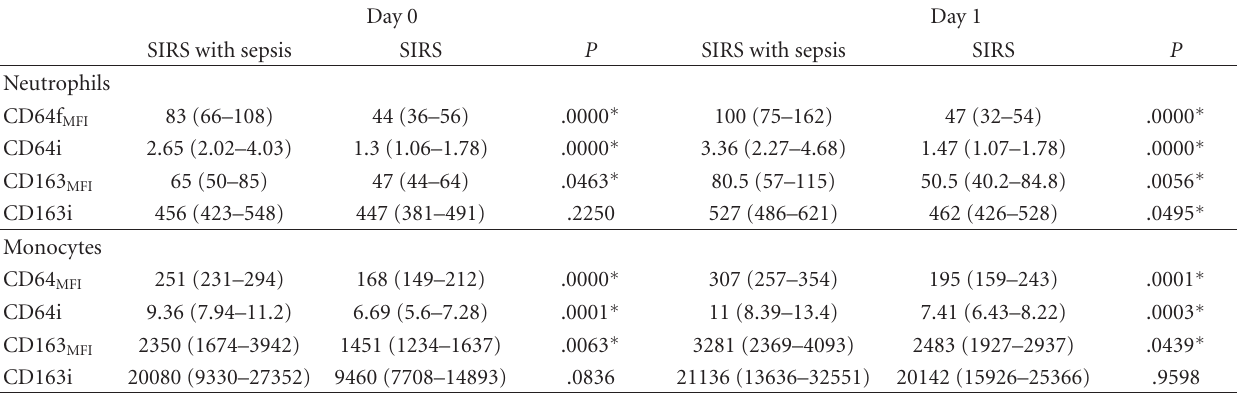
Table 2: Median CD64 and CD163 MFI and indexes (i) for neutrophils and monocytes with 95% confidence interval (CI) in critically ill neonates and children at the time of suspected sepsis (day 0) and 24 hours later (day